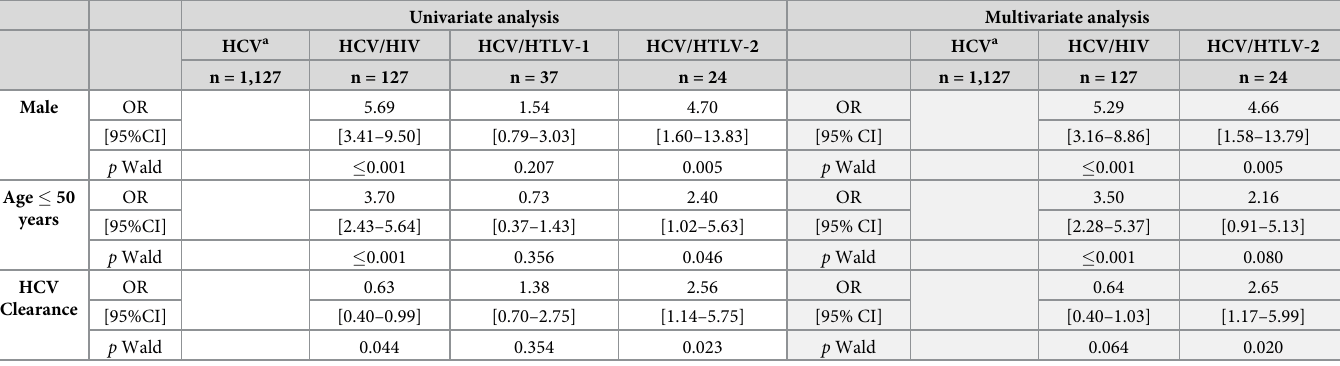
Table 4. Factors associated with HCV clearance in HCV infection and